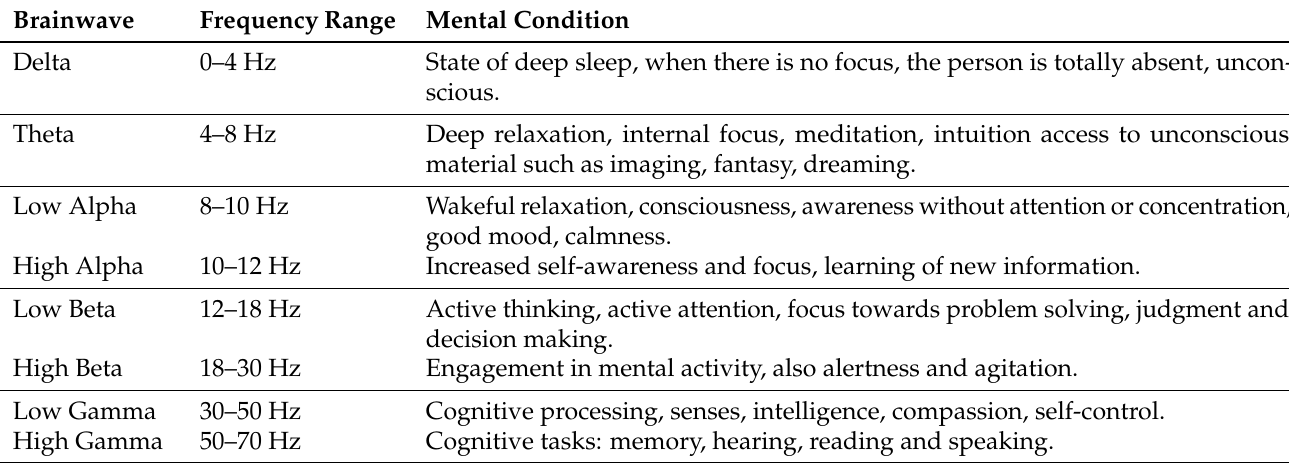
Table 1. Frequency ranges of the EEG signal